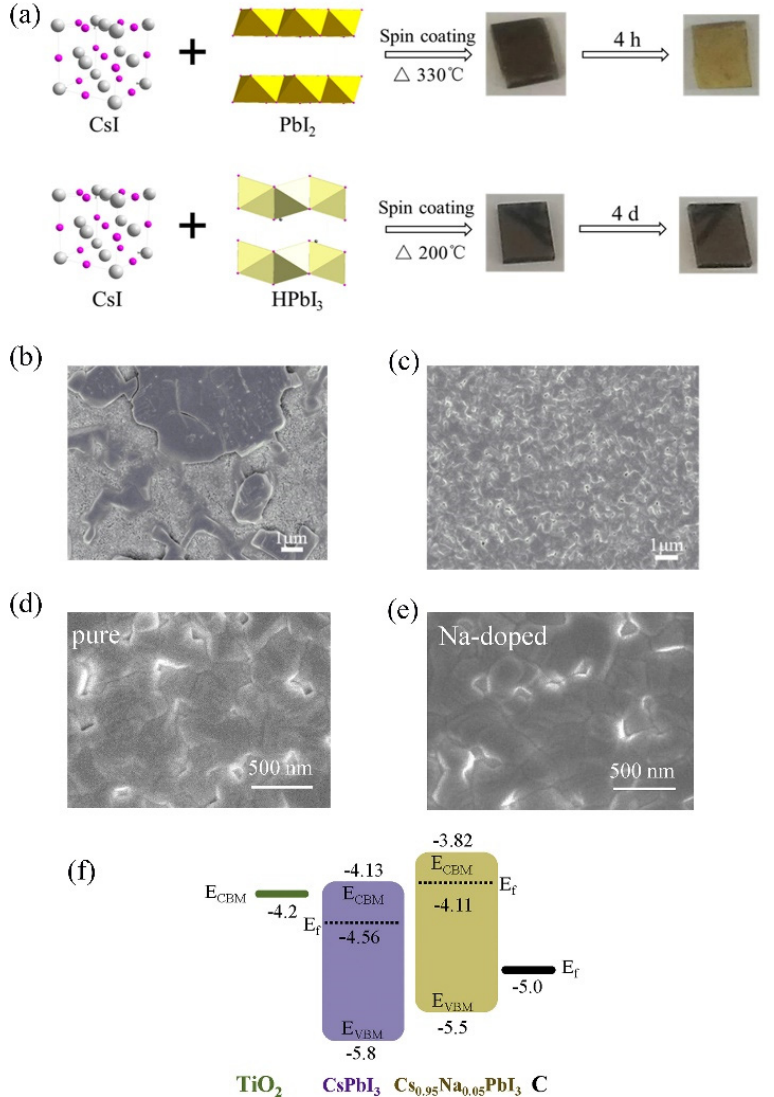
Figure 9. ( a ) Formation mechanism and phase structure of the CsPbI3 films from PbI2 precursor and HPbI3 precursor. SEM images of CsPbI2Br films prepared with ( b ) PbI2 precursor and ( c ) PbI2 precursor. Reproduced with permission [127]. Copyright 2018, American Chemical Society Publications. SEM images of CsPbI2Br films prepared without ( d ) and with ( e ) Na doping. ( f ) Energy-level diagrams of CsPbI3 C-IPSCs prepared without and with Na doping. Reproduced with permission [60]. Copyright 2019, Elsevier Inc. Publications.